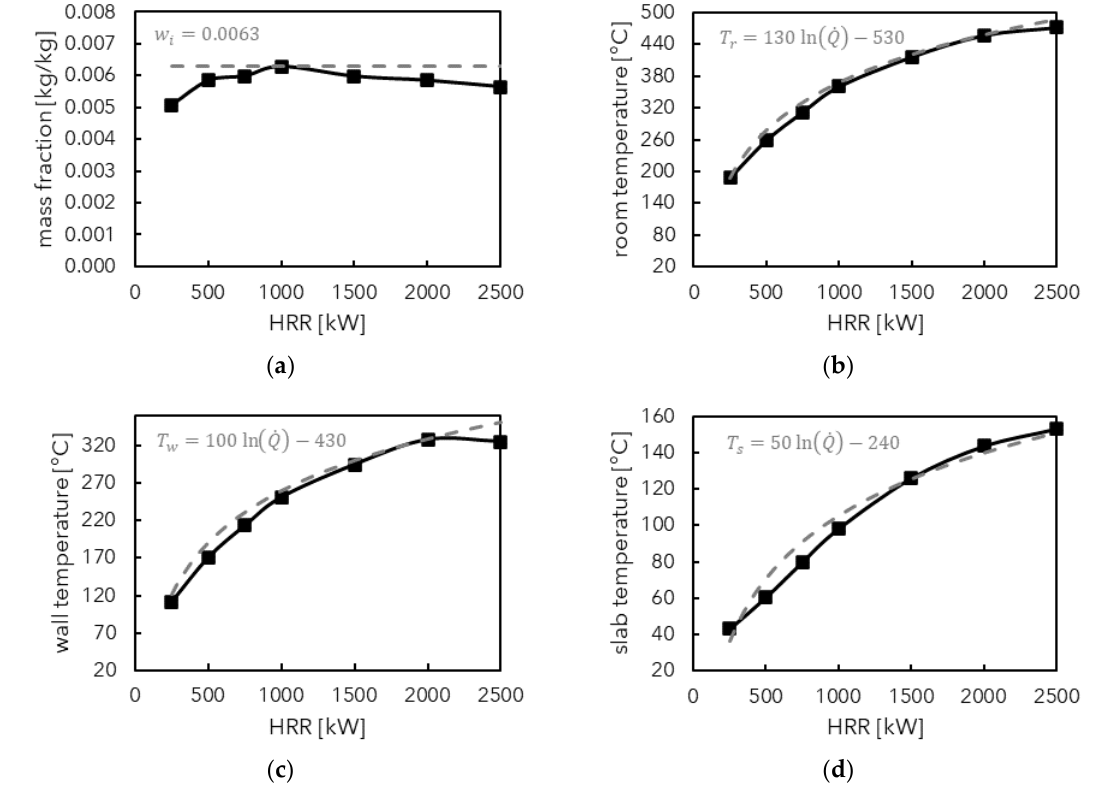
Figure 13. Results comparison for the HRR sensitivity study, measured for the full apartment volume at t = 460 s: ( a ) mean soot mass fraction; ( b ) mean room temperature; ( c ) mean wall temperature; ( d ) mean slab temperature. Black lines indicate the simulation data and grey lines indicate the best-fit correlations. Table 13. Proposed equations for estimating initial region parameters as a function of the maximum HRR, with an example provided for a 600 kW fire.